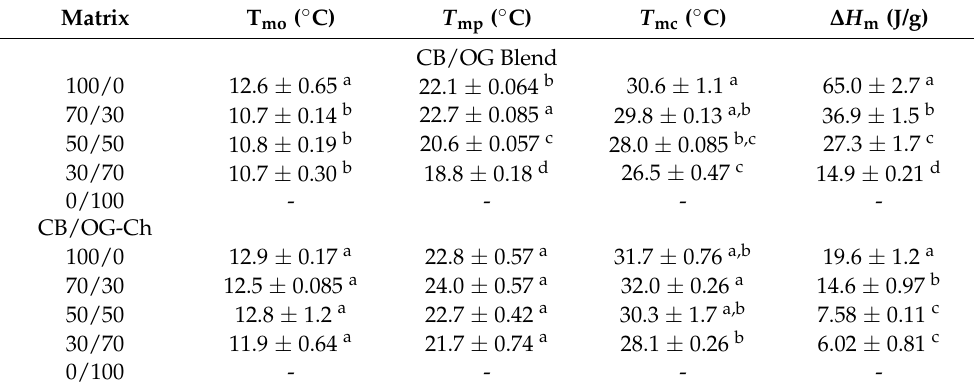
Table 6. Thermal parameters of the different formulated CB/OG blends and CB/OG-based chocolate (CB/OG-Ch)